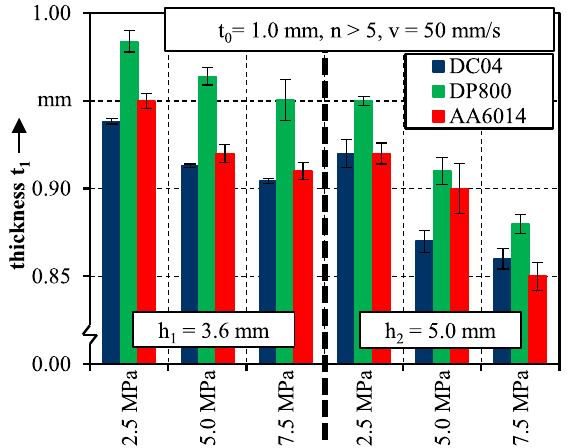
Fig. 4. Strip thickness after drawbead for a constant velocity of v = 50mm/s and drawbeads with h 1 and h 2 and the variation of the blankholder pressure p N = 2.5 – 7.5MPa.